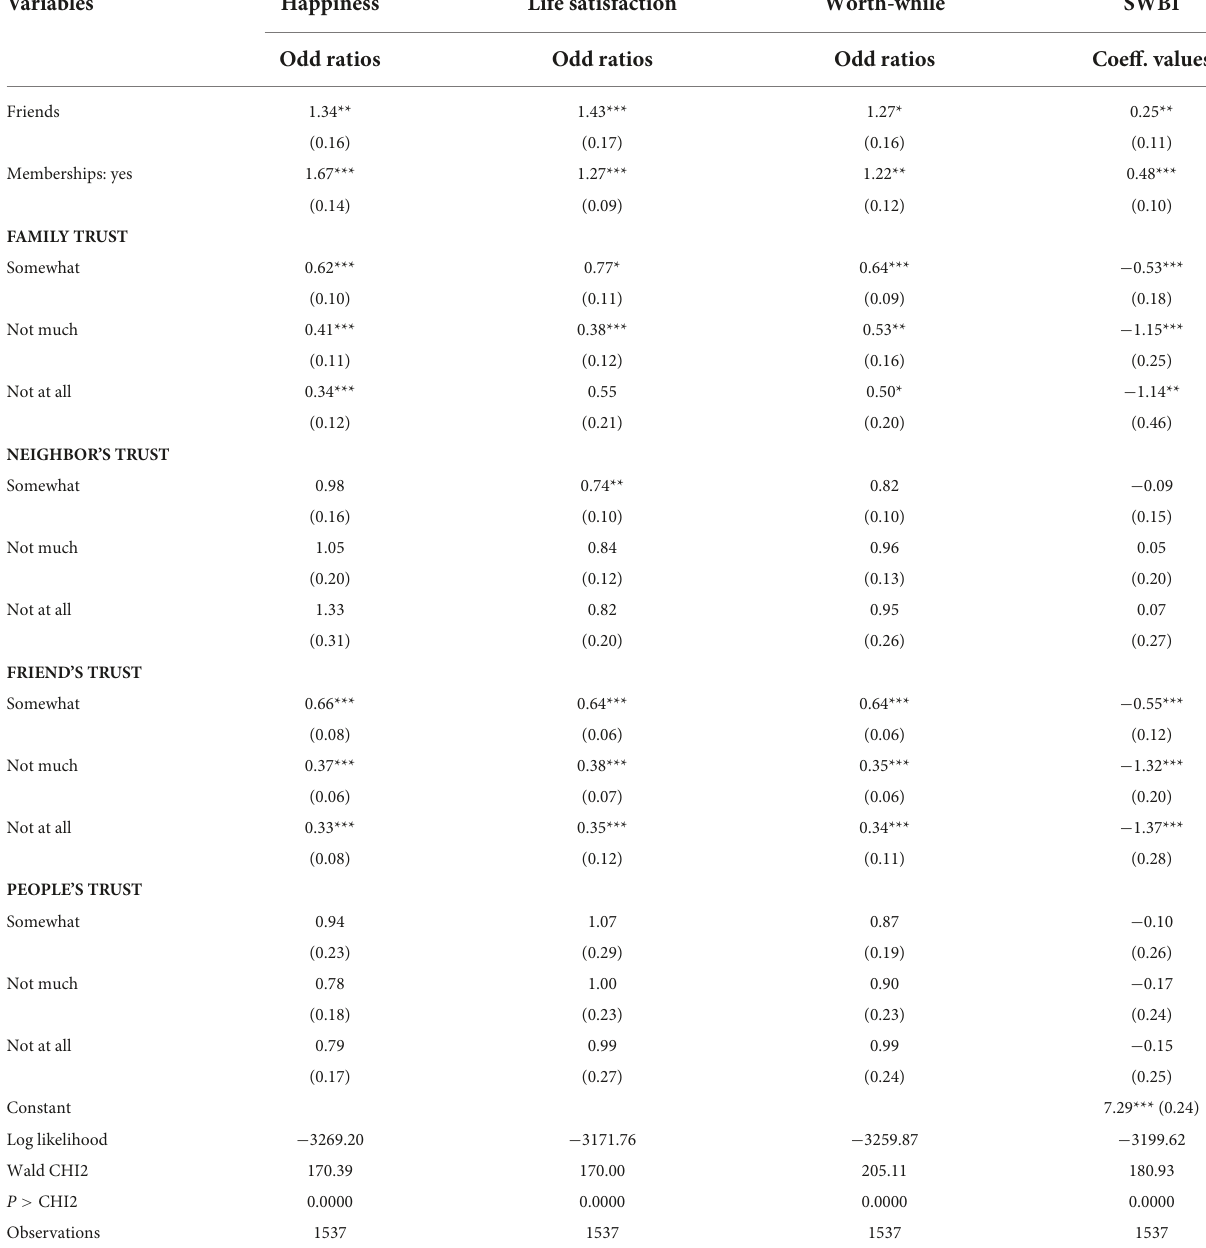
TABLE 8 Factors of social capital determinant of subjective wellbeing method: Ordered logit model Ie. Variables Happiness Life satisfaction Worth-while SWBI Odd ratios Odd ratios Odd ratios Coeff.